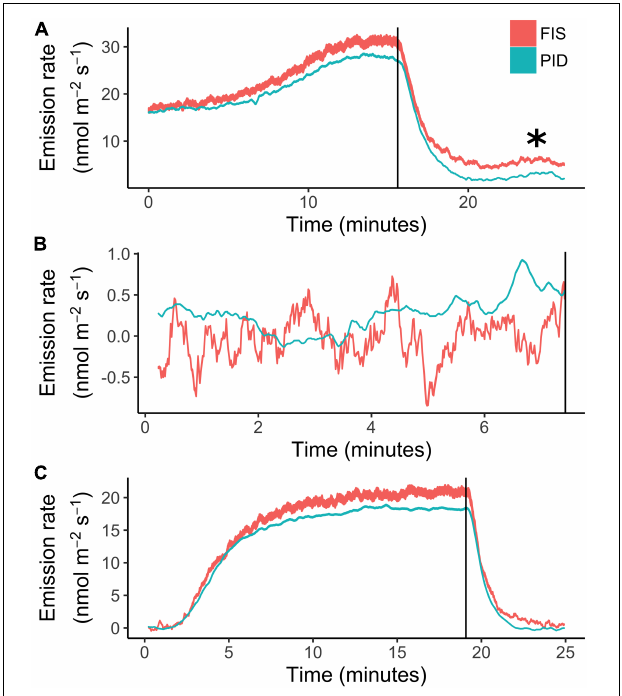
FIGURE 6 | Tandem real-time measurements of isoprene emission from tree leaves by photoionization detector (PID) employed in PORCO, and a Fast Isoprene Sensor (FIS). The instruments were set up in series, whereby the leaf environment was controlled by a Licor-6400 leaf cuvette, the cuvette return-air was subsampled by the PID, and the FIS subsampled air exhausted from the PID outlet. PID and FIS calibrations were performed simultaneously under the same series configuration. Time series data are ribbons, bounded by the emission rates estimated from pre- and post-measurement calibrations, demonstrating confidence relative to sensor responsivity drift. The asterisk in (A) indicates a post-illumination isoprene emission burst captured by both instruments. Species are (A) a temperate oak, Quercus sp., (B) an ornamental shrub, Hibiscus rosa-sinensis , and (C) a tropical tree, Malpighia glabra . Leaf (A) was acclimated to light before emission sampling. For leaves (B,C) , cuvette light was turned on at time 0. Vertical lines mark the time at lights-off [cuvette was opened at lights-off in (B)